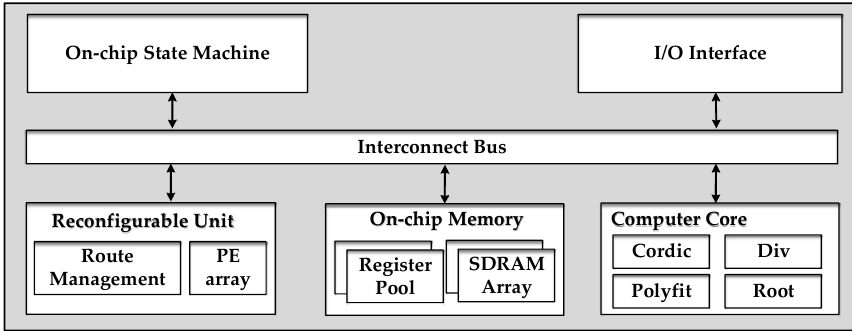
Figure 3. Field Programmable Gate Array (FPGA)-based architecture.